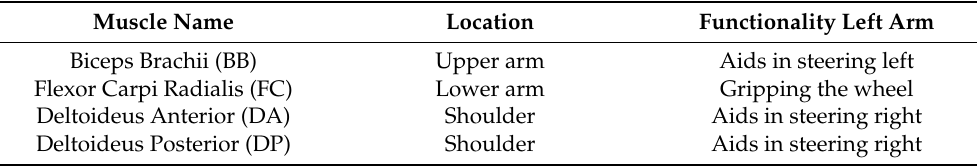
Table 1. Measured muscles and their functionalities [23].